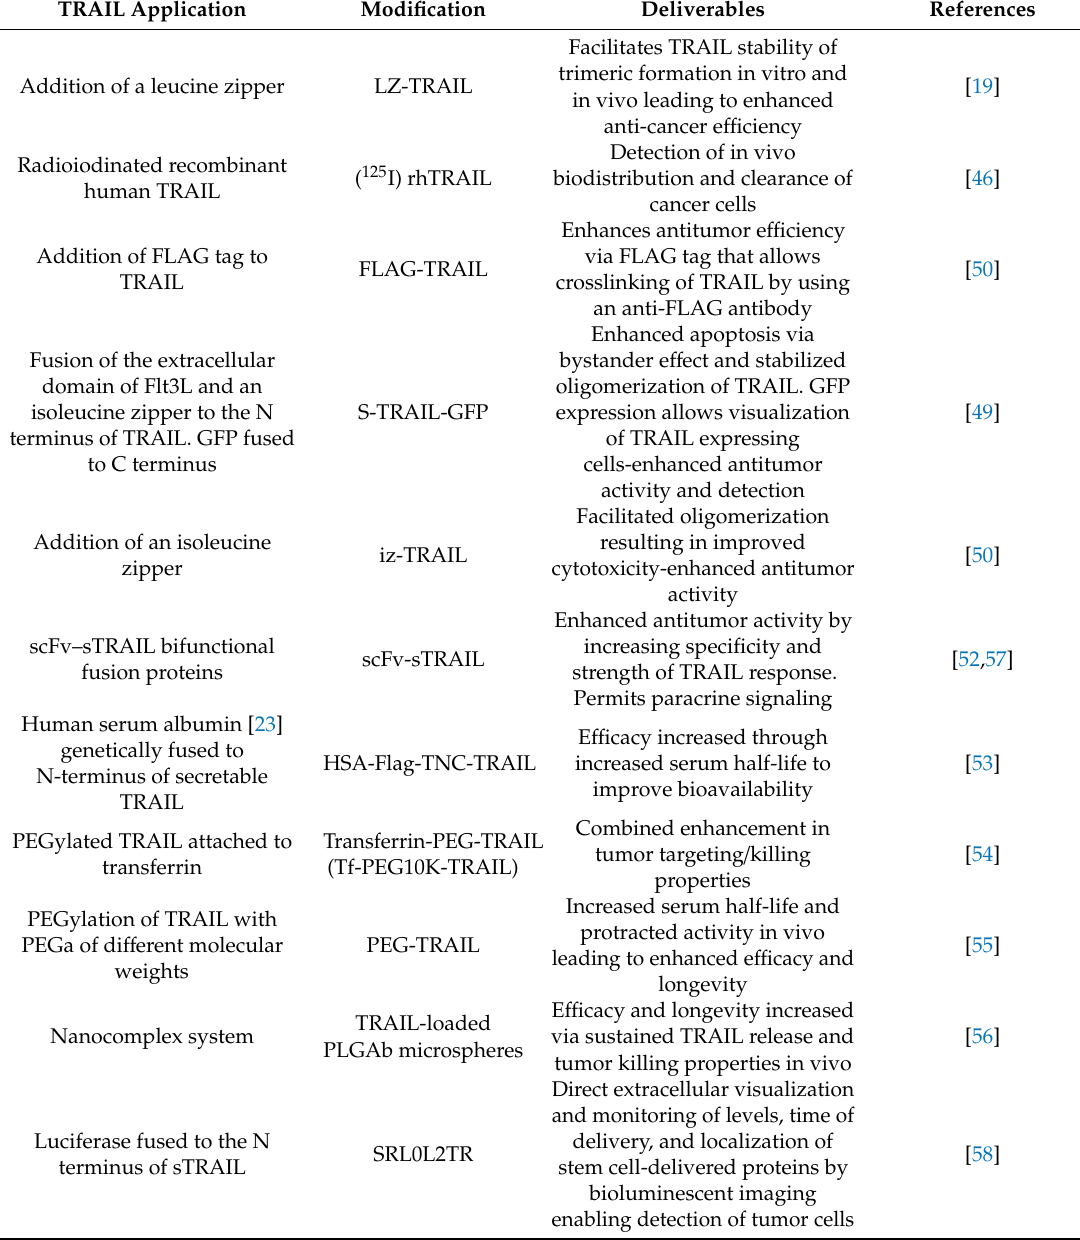
Table 1. Established applications of TRAIL anti-cancer